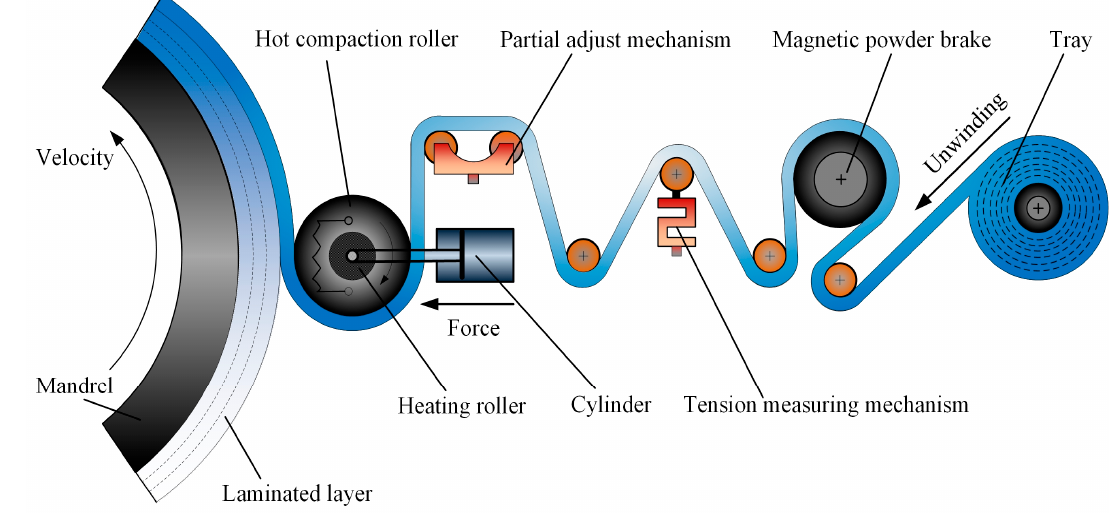
Figure 1. Schematic of the composites prepreg tape winding process.